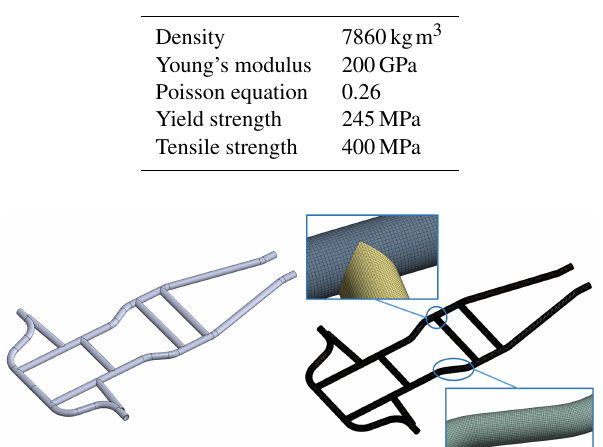
Table 7. Part material parameters (SS400).